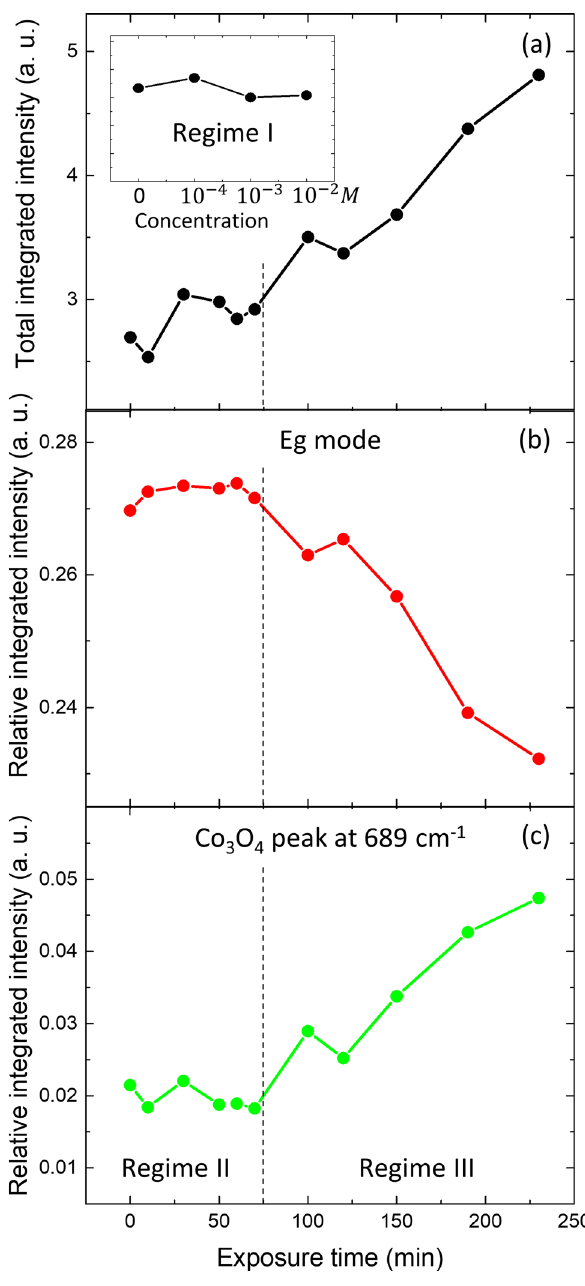
Figure 8. Evolution with exposure time at a 10 –2 M acid concentration of: ( a ) the total integrated Raman spectrum, ( b ) the relative integrated contribution of the Eg Raman peak (summing up the 2 phases), and ( c ) the relative integrated contribution of the Co 3 O 4 peak at 689 cm −1 . Regimes II (below 70 min.) and III (above 70 min) are clearly distinguishable in ( b ) and ( c ). The insert in ( a ) represents the total integrated Raman spectrum in Regime I: acid exposure times of 10 min at the lower